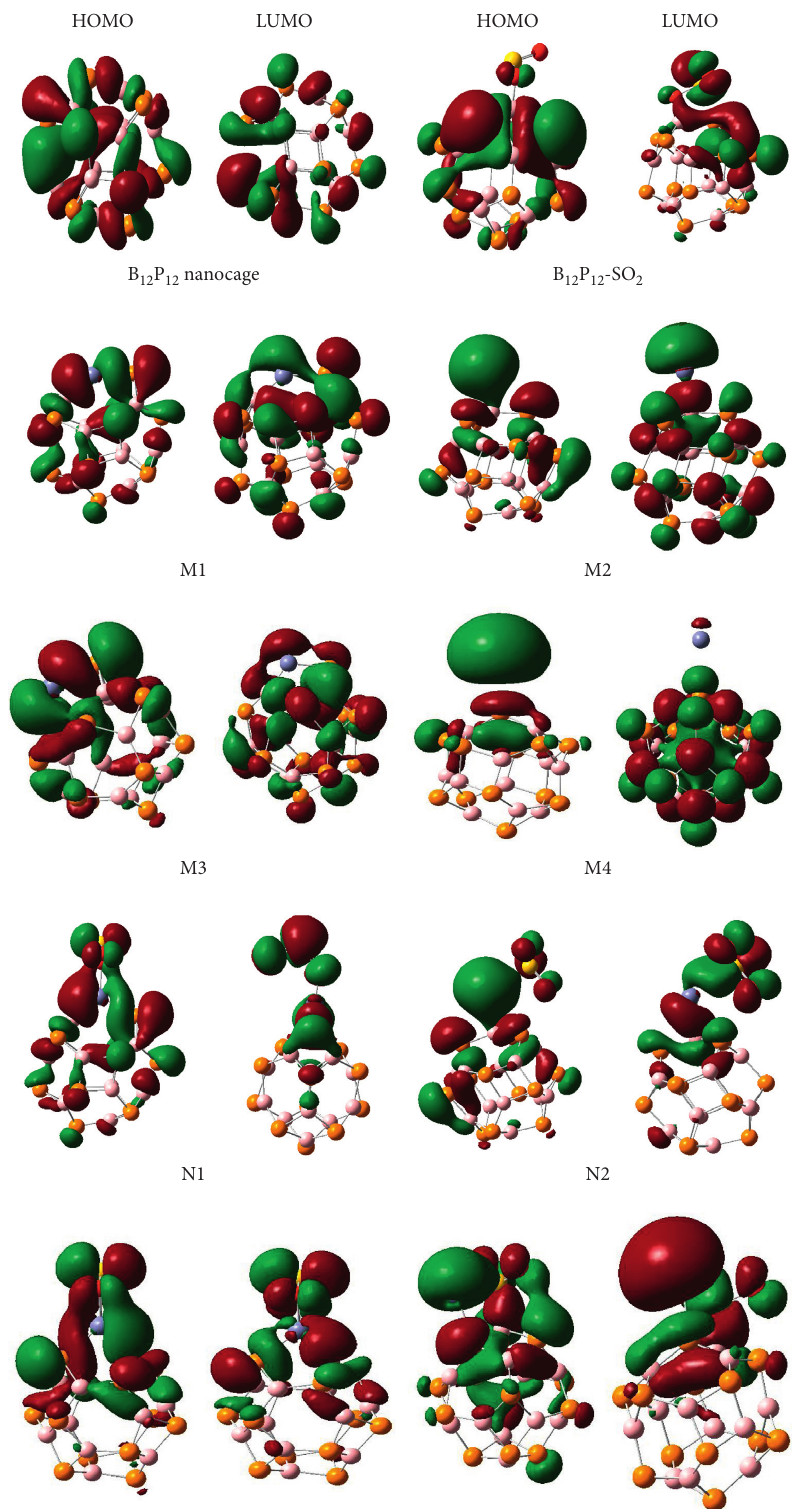
Figure 5: Side views of HOMO and LUMO of different